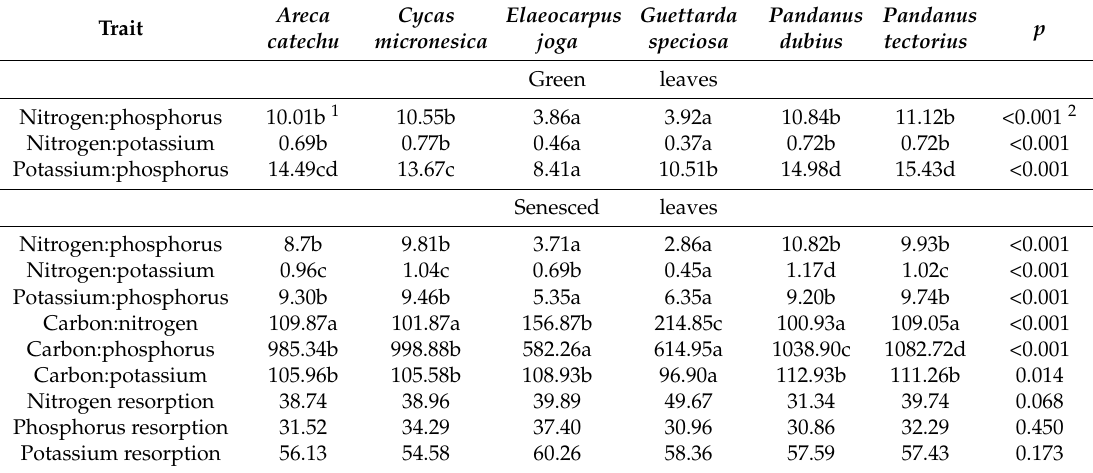
Table 3. Stoichiometry of nitrogen, phosphorus, and potassium concentrations in green and senesced D. guamense leaves and resorption efficiency of nitrogen, phosphorus, and potassium as influenced by host tree identity ( n =